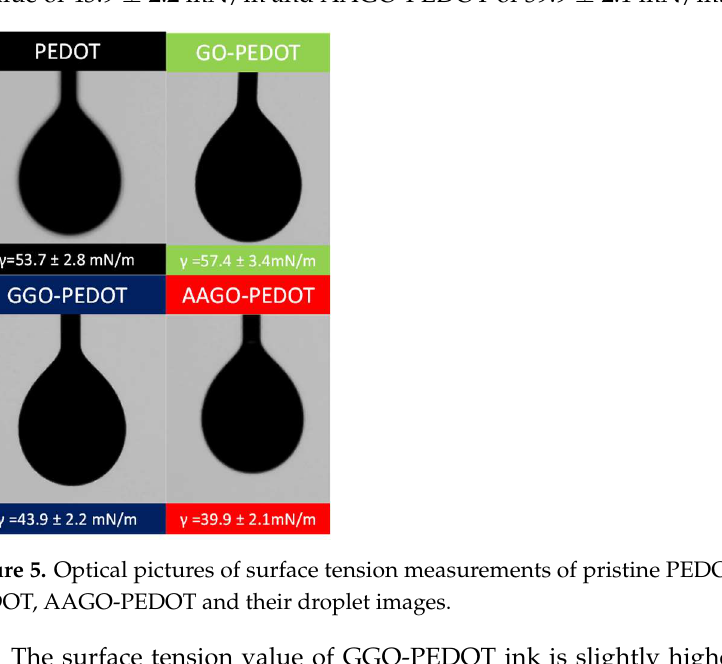
Figure 5. Optical pictures of surface tension measurements of pristine PEDOT, GO-PEDOT, GGO- PEDOT, AAGO-PEDOT and their droplet images.